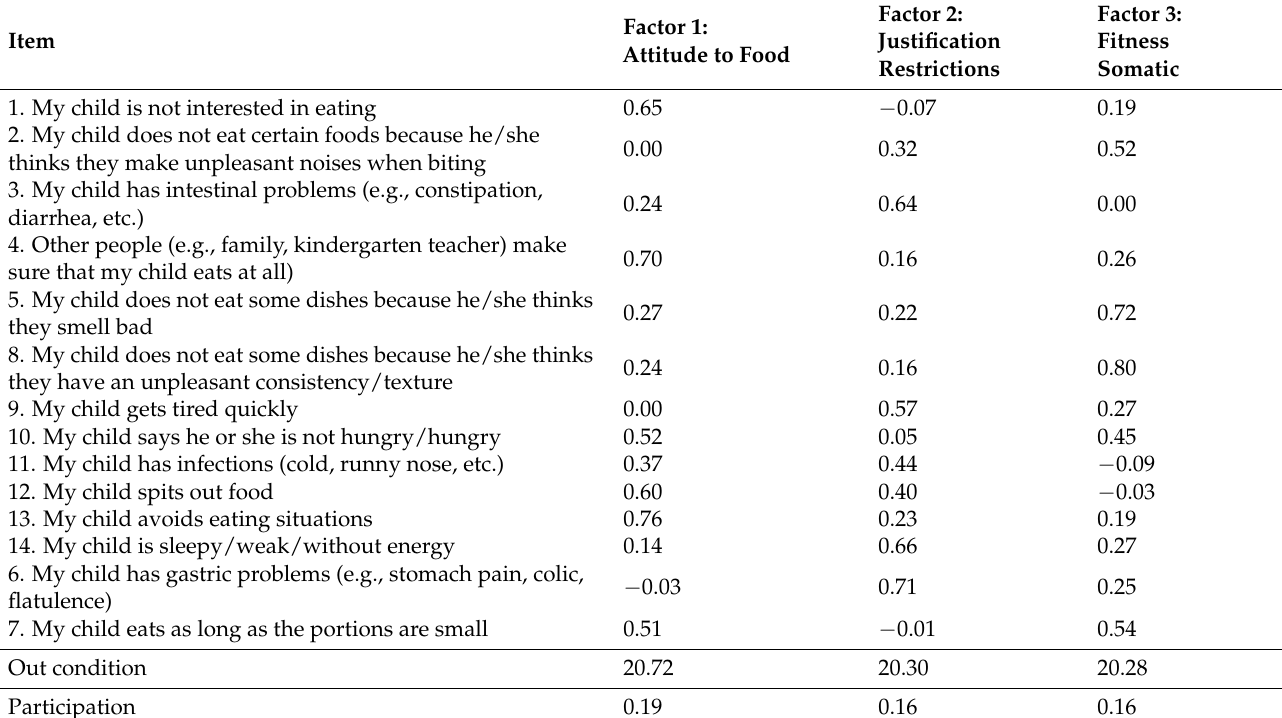
Table 5. EFA ARFID-Q-PR factor analysis (N = 167).